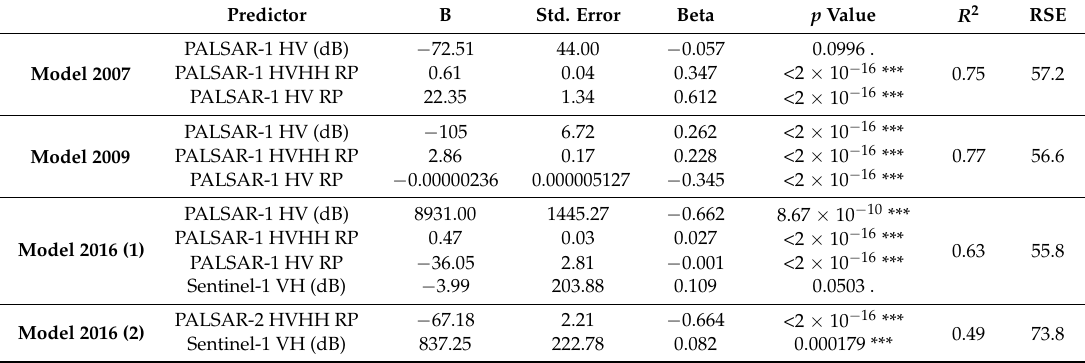
Table 2. Overview of the used variables for the different MLR models per year and the R 2 and residual standard error (RSE) for the calibration of the model (RP = higher texture run percentage). Predictor B Std.